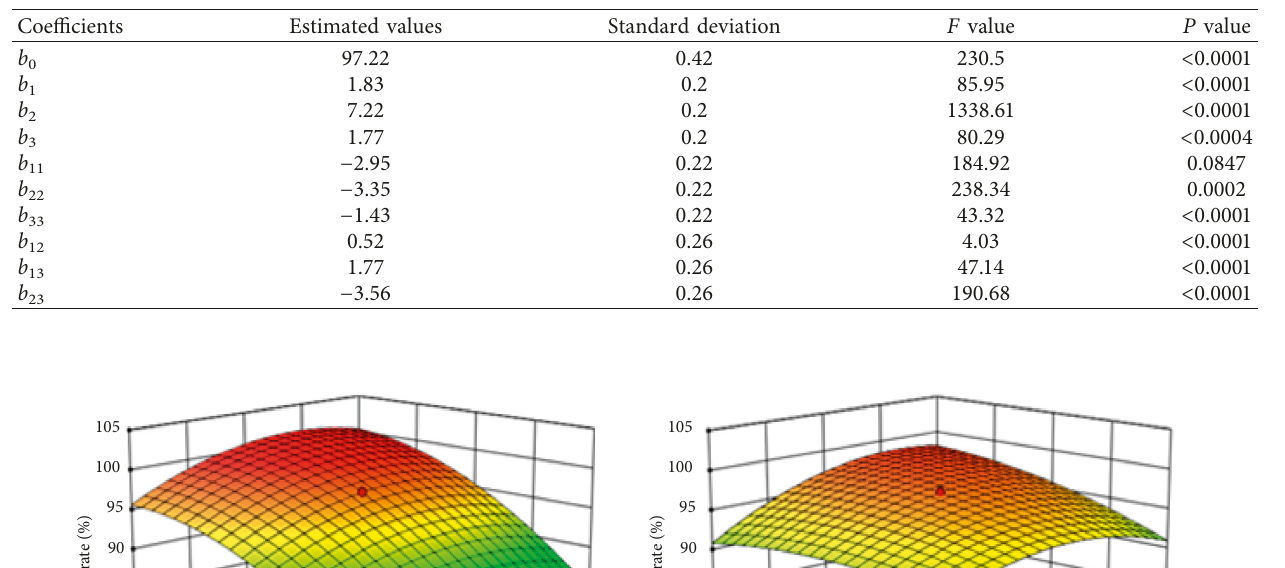
Table 6: Estimated regression coefficients and their significance.